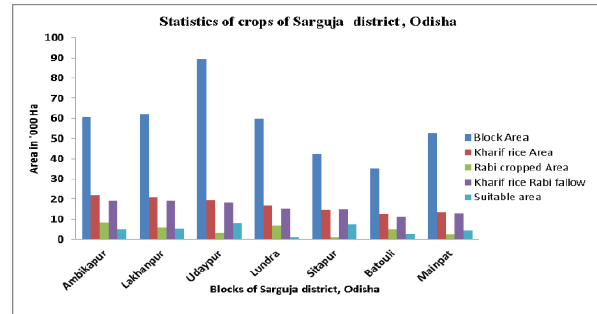
Figure 6: Block wise maps of Average temperature, PAWC, LSWI, Kharif rice mask, post kharif rice and rabi fallow and suitable area for Sarguja , Chhattisgarh